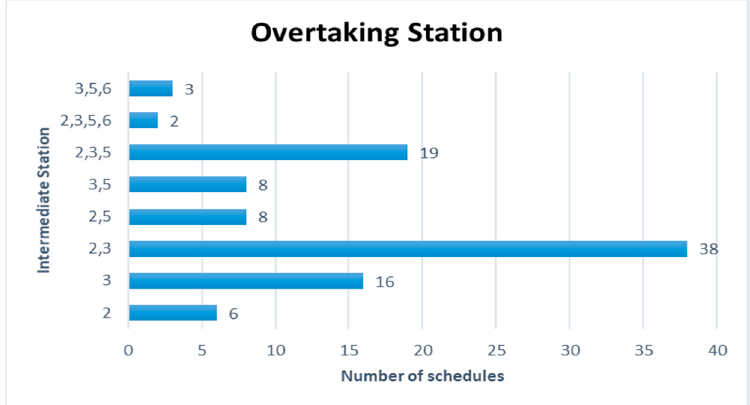
Figure 12. Overtaking Station for Case 2.